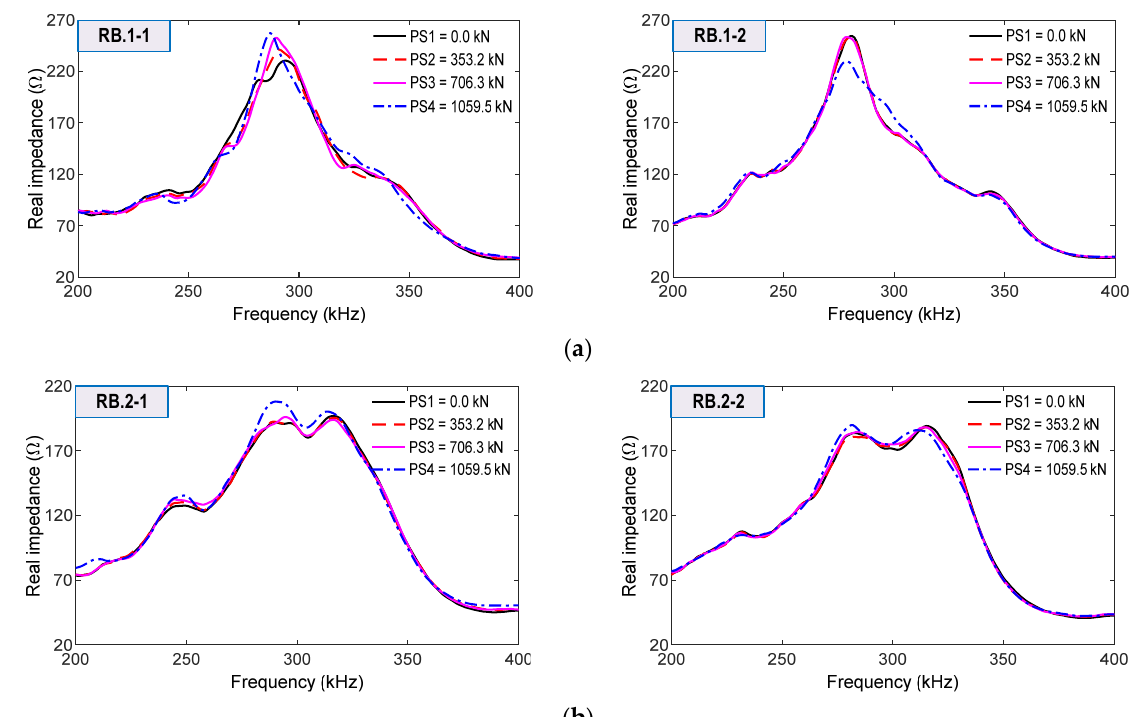
Figure 19. Impedance signatures of smart rebars for loading cases PS1–PS4: ( a ) Smart rebars RB.1-1 and RB.1-2 on Rebar 1; ( b ) Smart rebars RB.2-1 and RB.2-2 on Rebar 2.